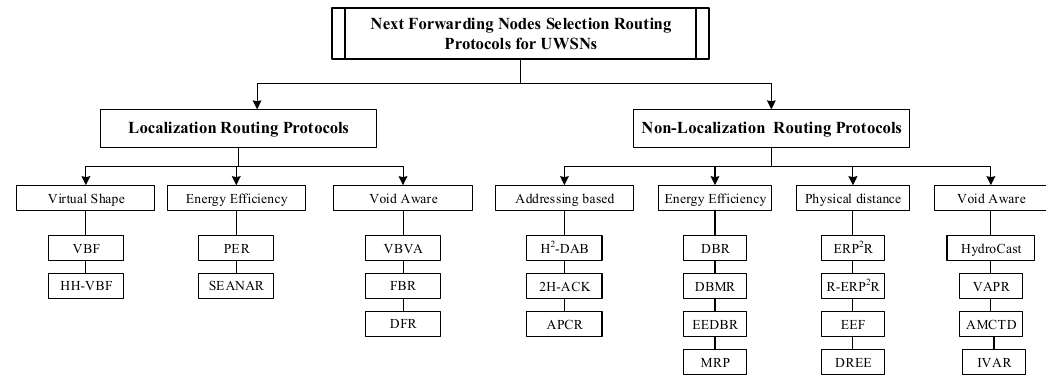
Figure 1. Taxonomy of next forwarding node selection in UWSNs.